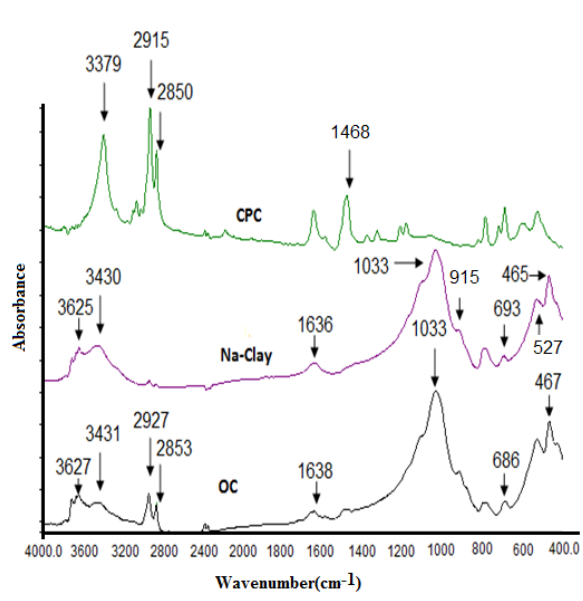
Figure 1: Fourier transformation Infrared (FTIR) spectra of Na-clay, Organoclay(OC) and cetylpyridinium